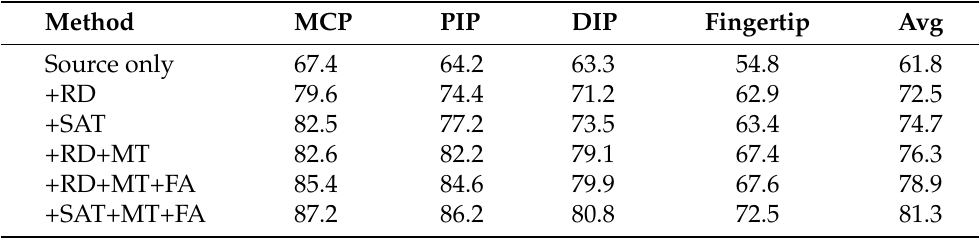
Table 3. Ablation study results of the proposed